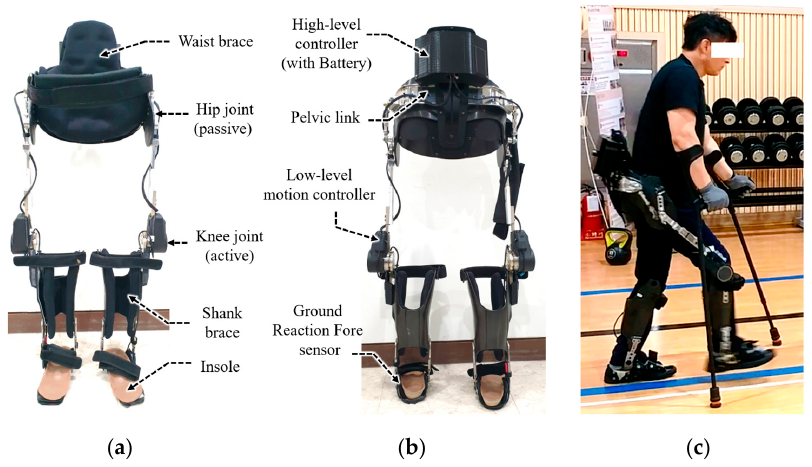
Figure 2. The system configuration of the knee activated exoskeletal gait orthosis. ( a , b ) is the front and rear side view of the developed orthosis system respectively. The control system consists of high level and low level controllers. The gait phase is controlled by a high level controller and detailed control signals are generated by low level controllers. The developed system can be used like a reciprocating-gait-orthosis (RGO) by using the pelvic-link. ( c ) shows a paraplegic patient perform gait training wearing the developed